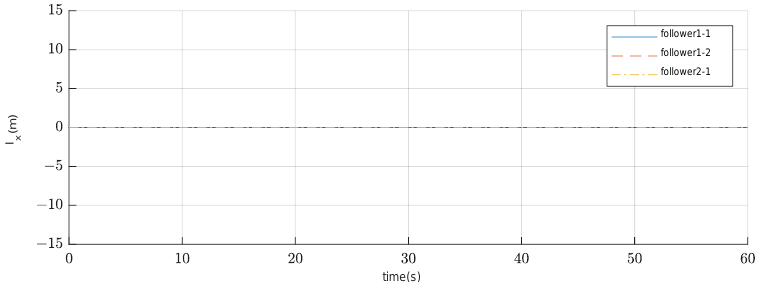
Figure 30. The variation curves of l x for each follower during the movement. Follower 1-1 indicates the position of follower No.1 in sub-fleet No.1, and follower 2-1 indicates the position of follower No.1 in sub-fleet No.2.